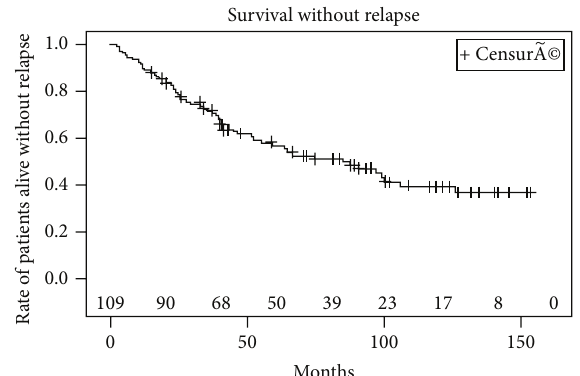
Figure 1: Kaplan-Meier curve of biochemical recurrence free survival using Phoenix definition (nadir + 2 ng/mL).